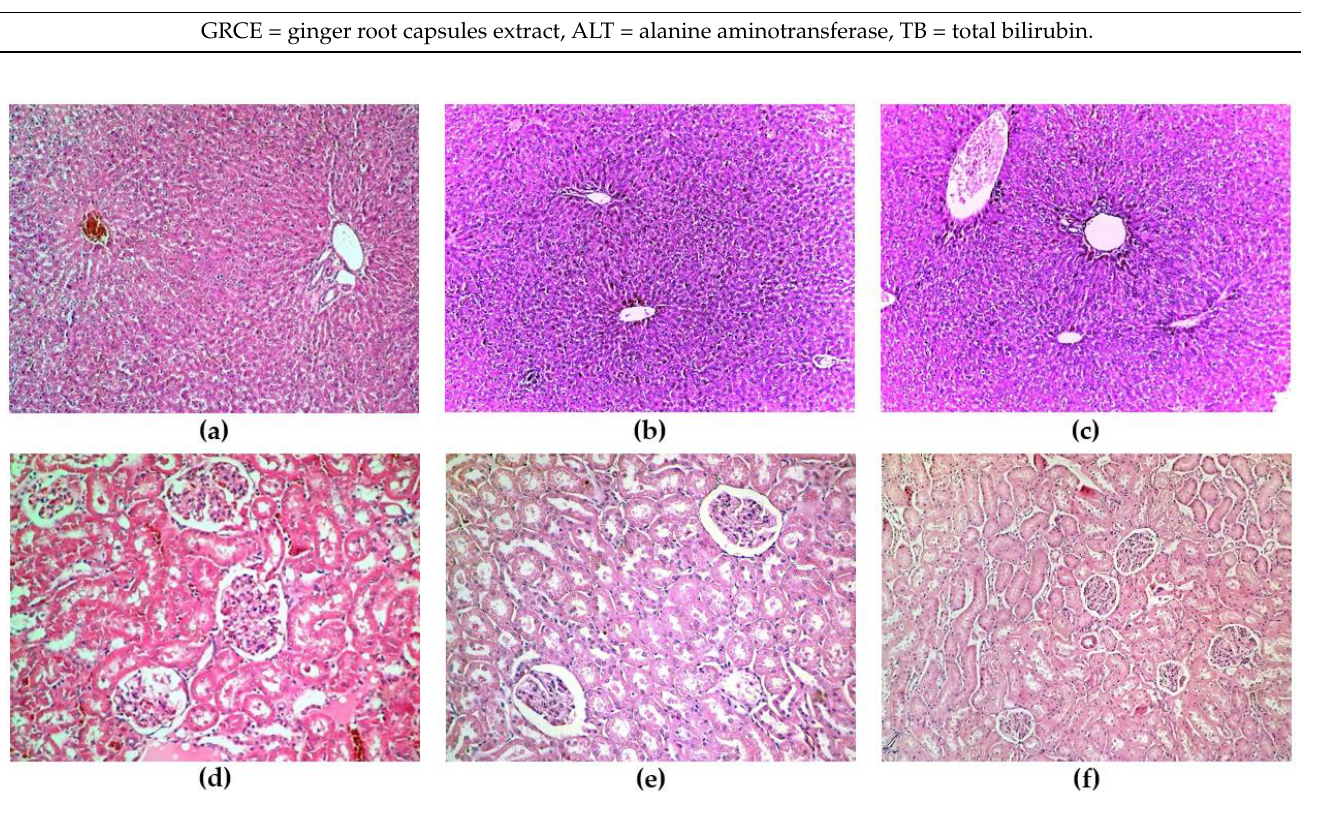
Table 4. Weight and biochemical evaluation for toxicity.